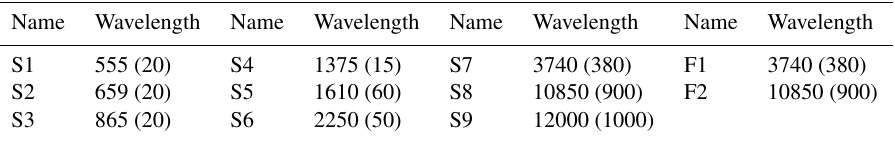
Table 2. SLSTR spectral bands. Name and central wavelengths (bandwidth) in nanometres (Coppo et al., 2013). S1–S3, S4–S6 and S7–S9 are respectively, visible (VIS), short-wave and infrared (SWIR), and infrared bands. F1 and F2 are fire detection bands. Name